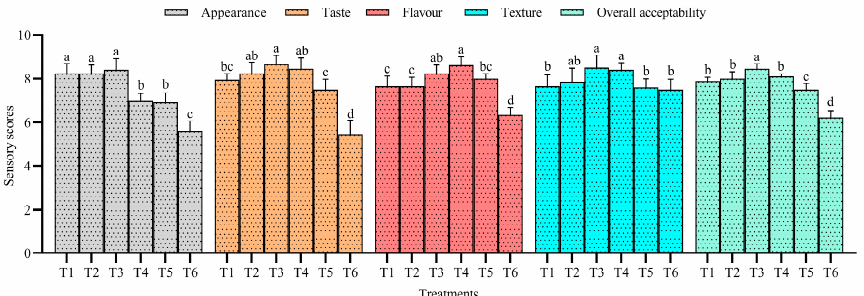
Figure 4. Sensory scores of the various formulations of ready-to-cook gluten-free snack. (Values are mean ± SD, n = 10; values within an attribute with different superscripts are significantly different ( p ≤ 0.05)).